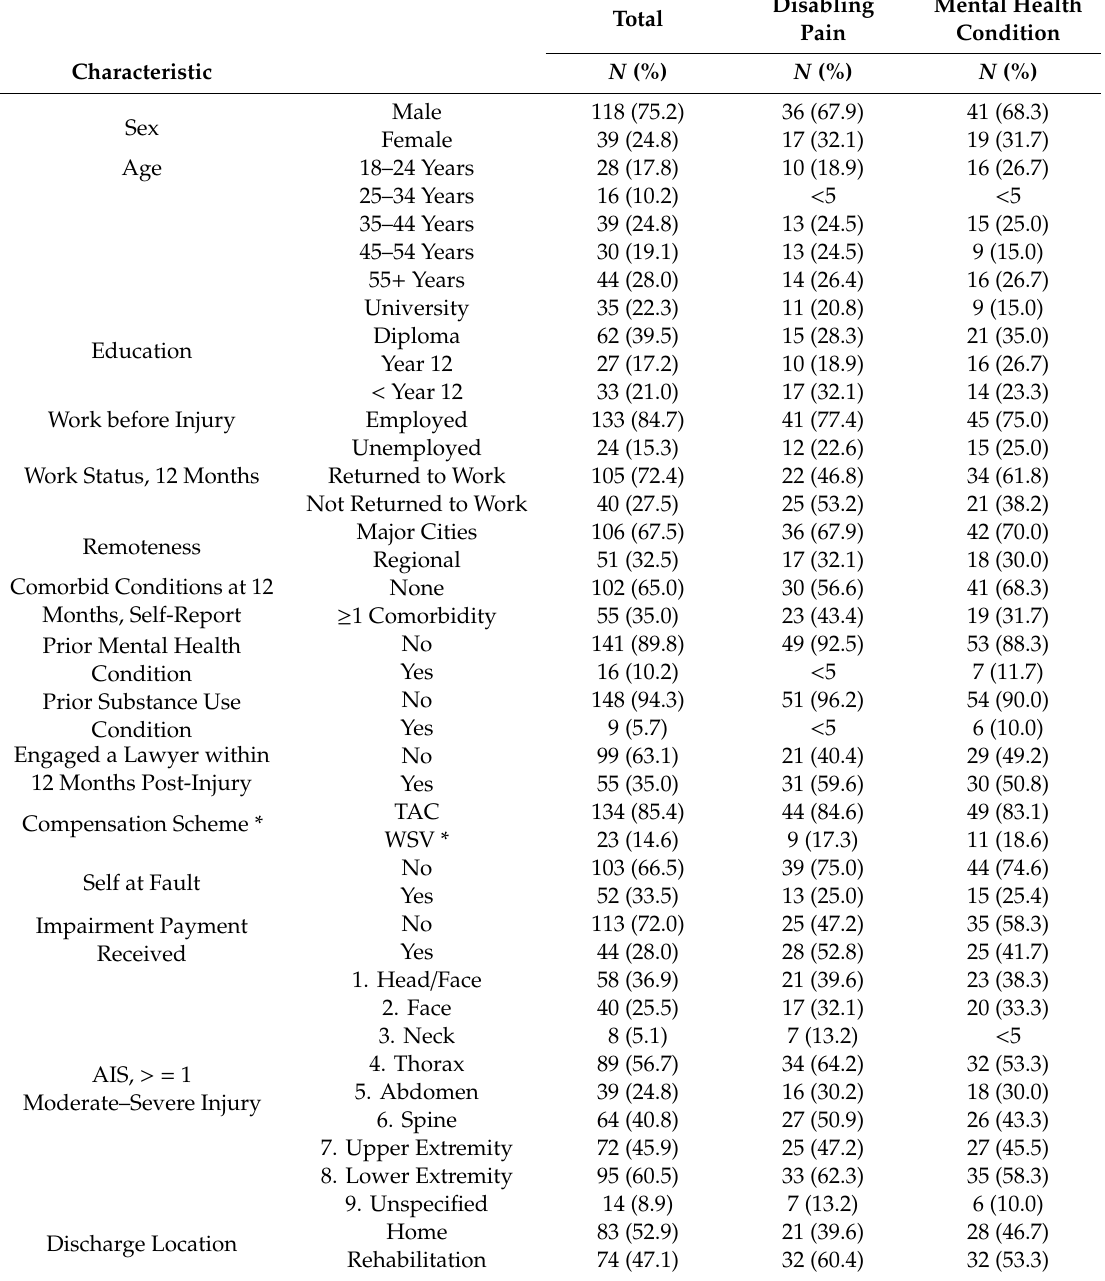
Table 2. Participant Demographic and Injury Characteristics and Prevalence of Disabling Pain or Probable Mental Health Condition at 12 Months